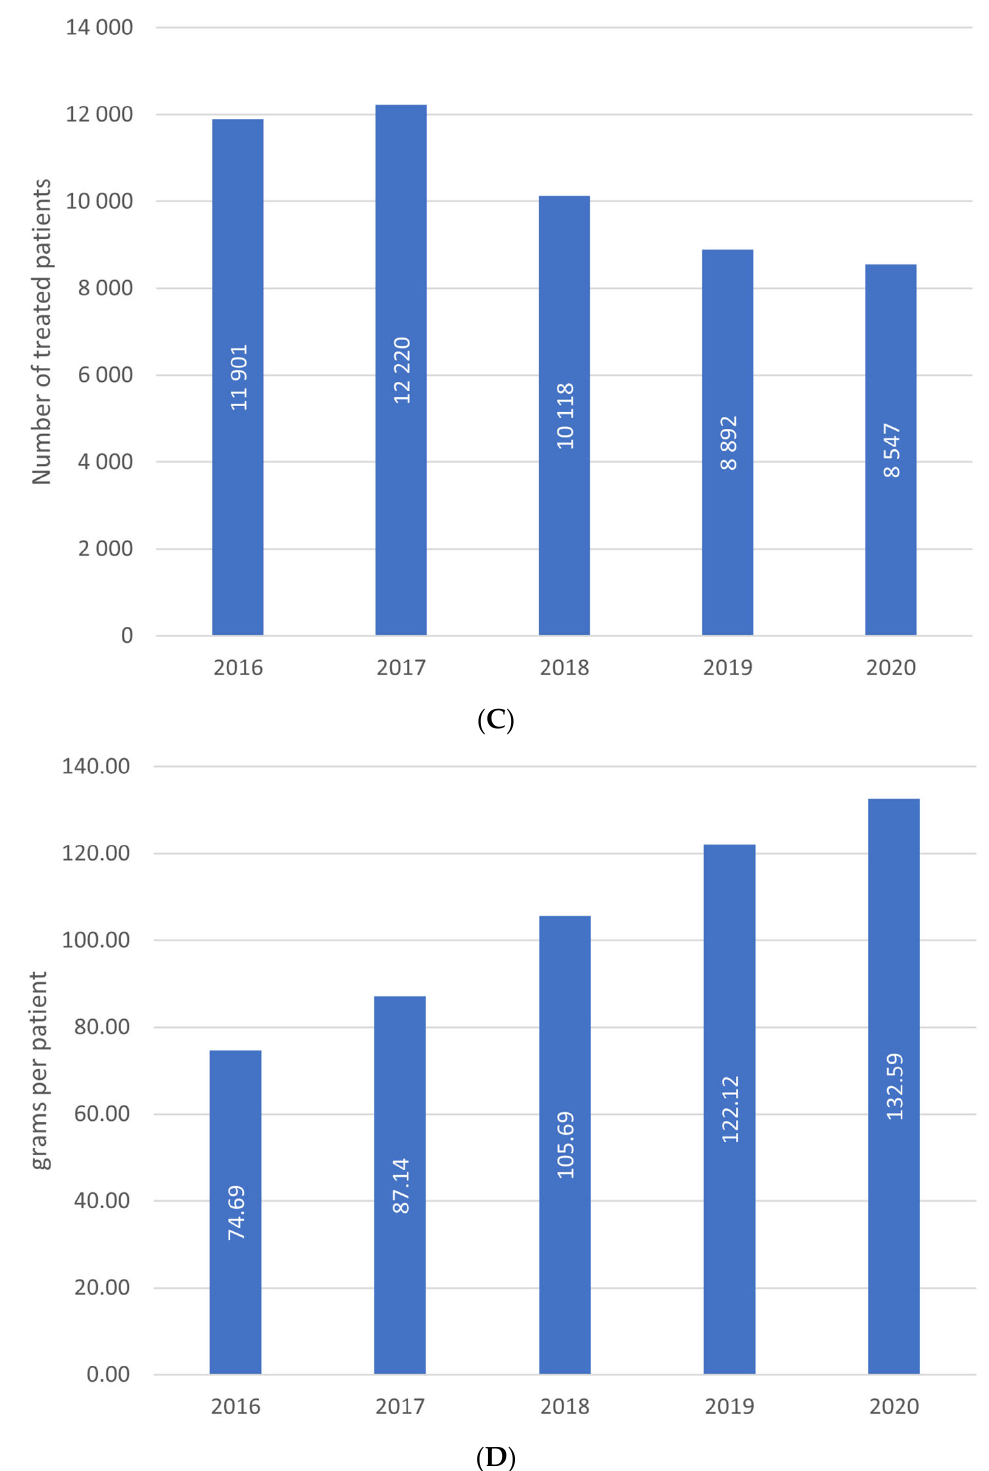
Figure 1. ( A ) Total annual consumption of immunoglobulins (in grams) in Poland. ( B ) Total annual consumption of immunoglobulins per 1000 inhabitants in Poland. ( C ) Total number of patients treated of immunoglobulins per year in Poland. ( D ) Mean annual consumption of immunoglobulins in Poland.